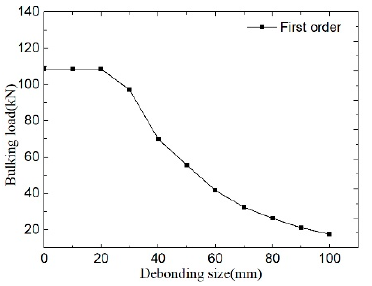
Figure 2. The influence of debonding sizes on buckling load.